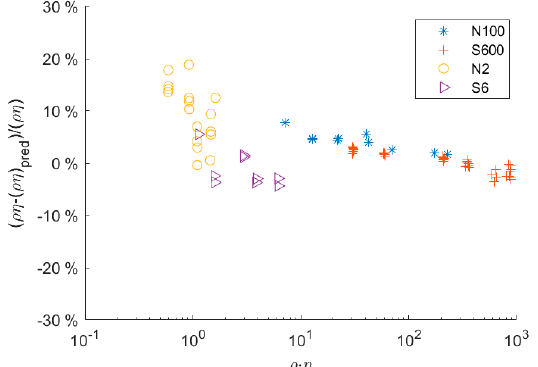
Figure 7. Relative deviation of the predicted and actual ρη value, where ρ is the density and η the dynamic viscosity.